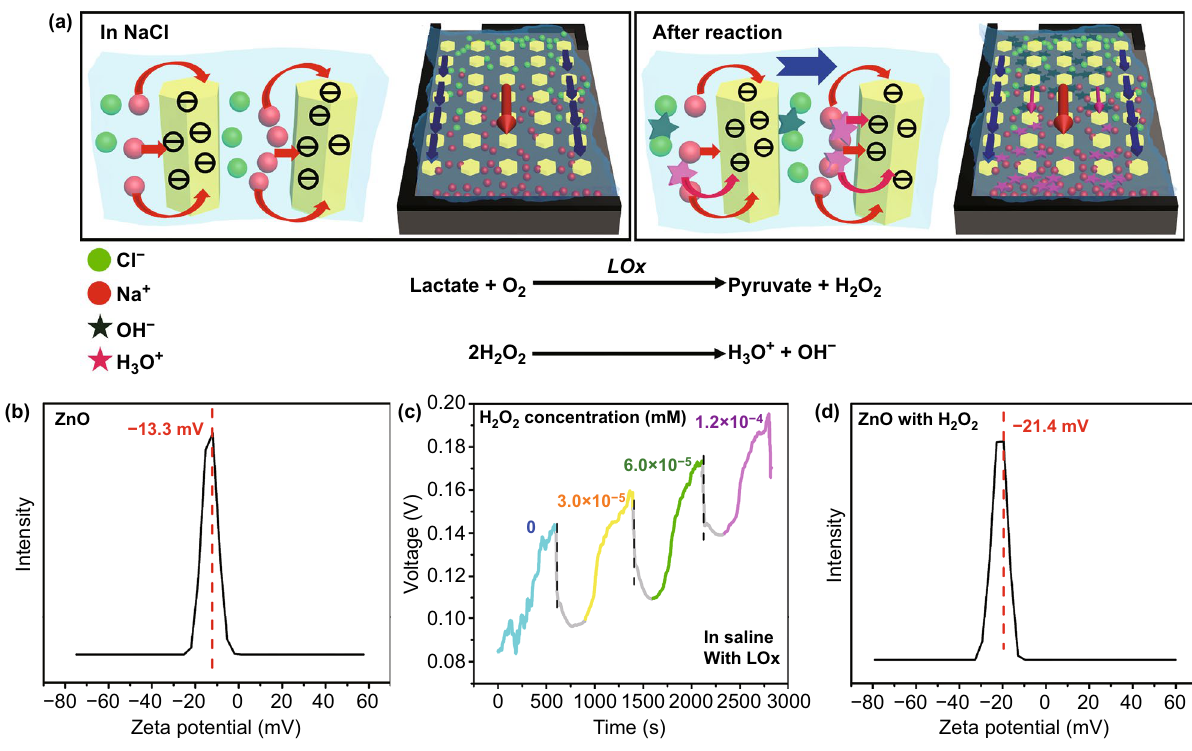
Fig. 4 a Power-generating and biosensing process of the perspiration analyzing sites. b Zeta potential of ZnO NWs. c Outputting voltage of the device with LOx modification against different hydrogen peroxide concentrations. d Zeta potential of ZnO NWs with hydrogen